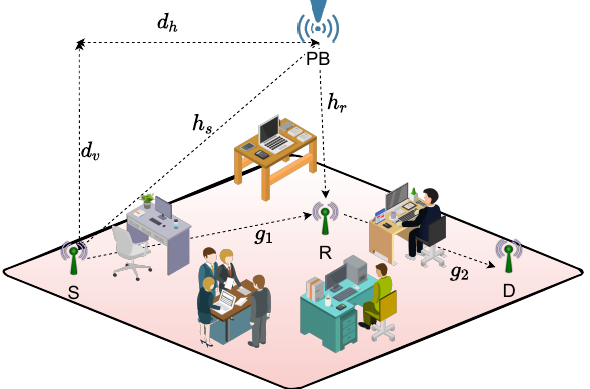
Figure 1. Wireless-powered DH AF relaying system model where S and R harvest their energy from a dedicated PB. S and R use their harvested power for data transmission.